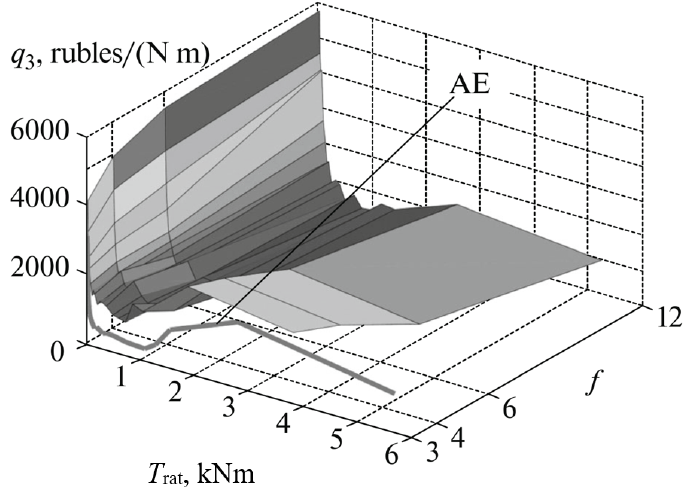
Figure 8. Dependency of the unit cost of the frequency converter on the number of phases f and the nominal torque of the operating mechanism T.